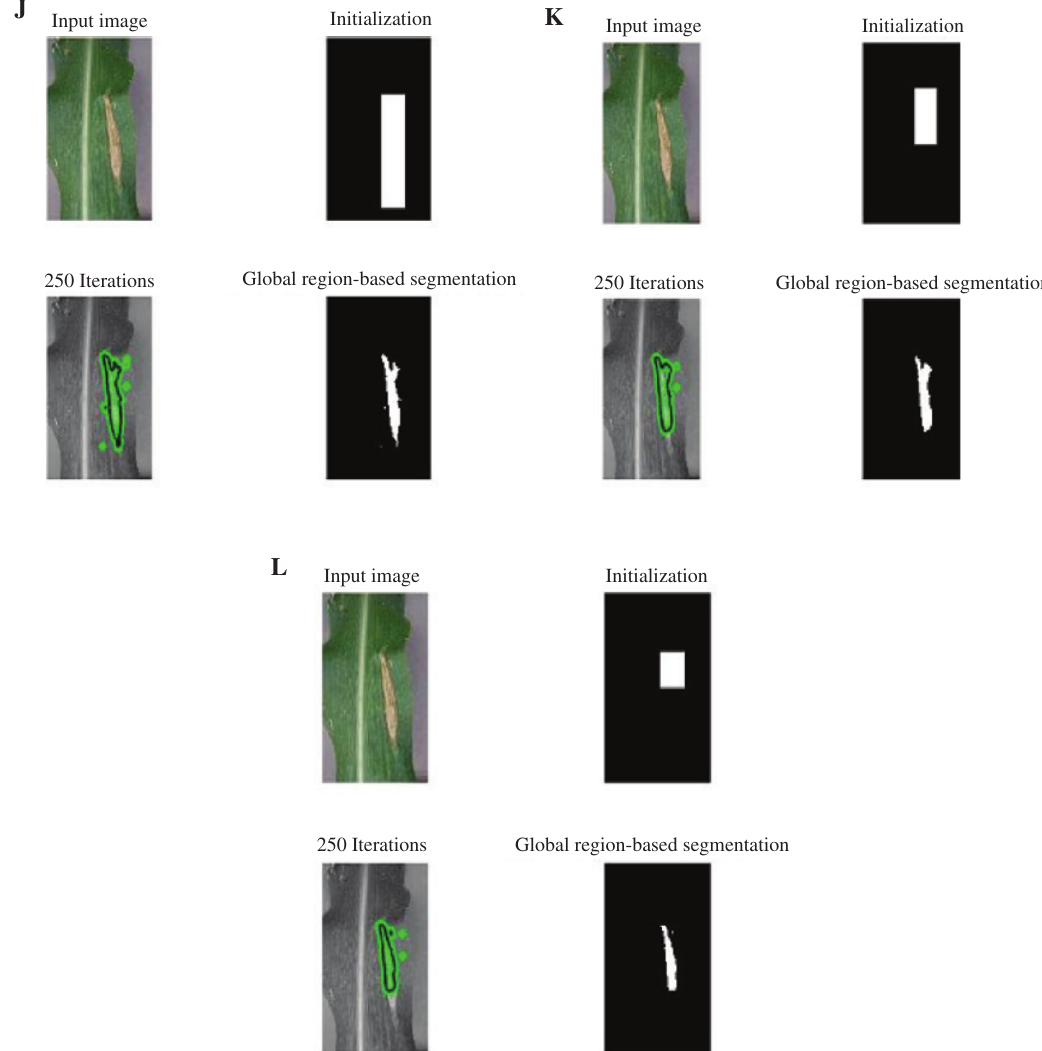
Figure 9: The Output Result of Image